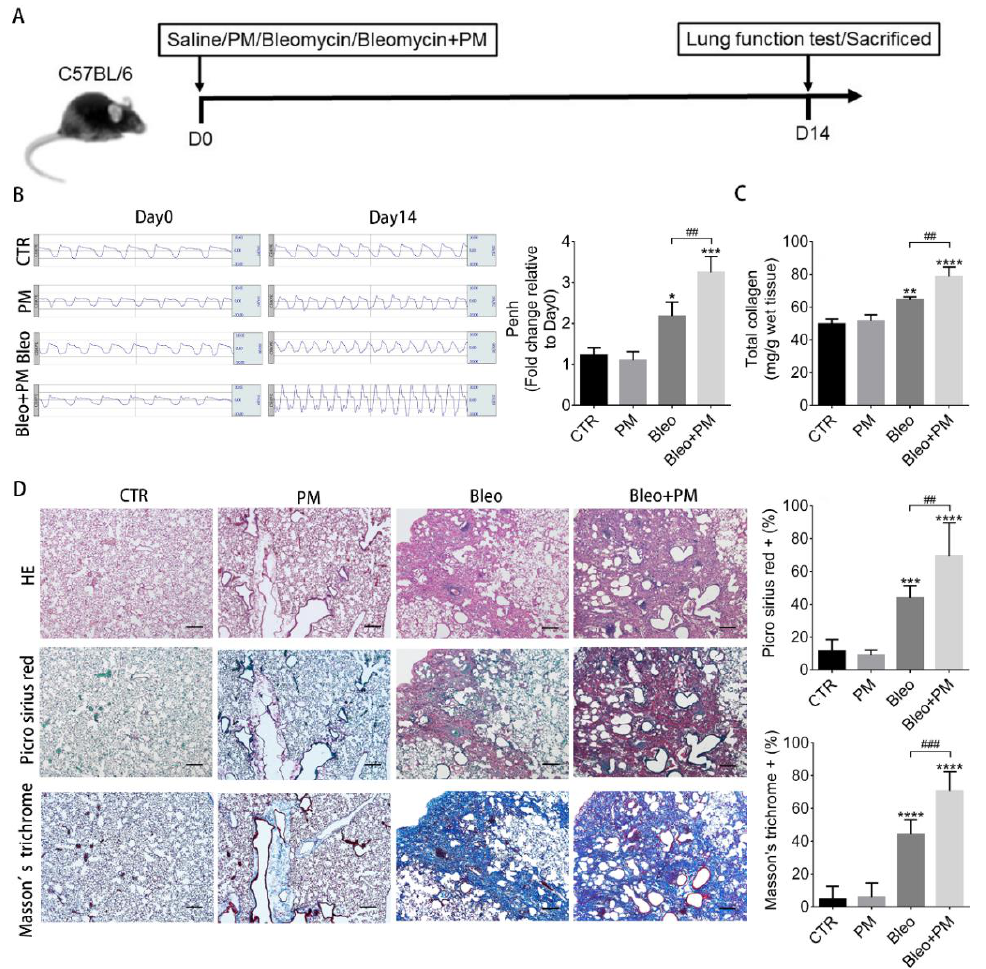
Figure 1. Particulate matter (PM) enhances lung function deterioration and pulmonary fibrosis. ( A ) C57BL/6 mice were intratracheally instilled with saline (Control), 200 μg PM, 2 U/kg bleomycin (Bleo) or 200 µg PM plus 2 U/kg bleomycin (Bleo+PM) at day 0. ( B ) The lung function test for the Penh value was performed at 14 days. The mice were then sacrificed, and the lung tissues were subjected to ( C ) total collagen content measurement and ( D ) histochemical analysis with H&E, Picro Sirius red, and Masson’s trichrome staining (40 × ). ( B , C ) Quantification data are expressed as the mean ± SD of three mice in each group. ( D ) Quantification data are expressed as the mean ± SD of six mice in each group. (scale bar: 200 µm) * p < 0.05, ** p < 0.01, *** p < 0.005, **** p < 0.001 versus CTR as determined by one- way ANOVA. ## p < 0.01, ### p < 0.05 as determined by one-way ANOVA.